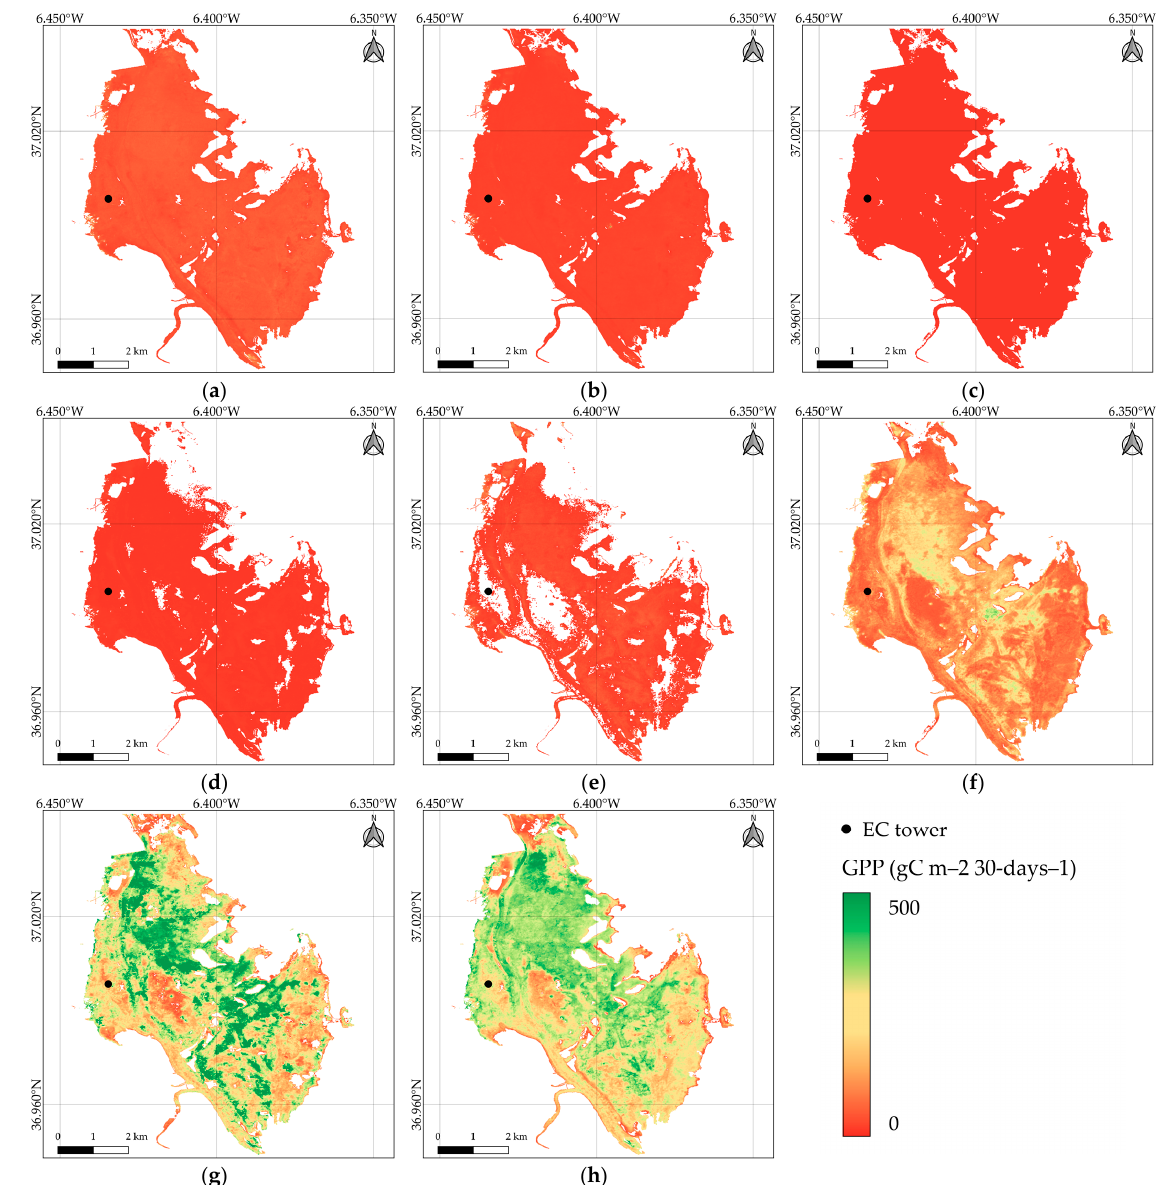
Figure 12. Monthly GPP maps obtained using a single composite image per month. The maps show the spatial and temporal pattern of GPP (gC m − 2 month − 1 ). ( a ) October 2020, ( b ) November 2020, ( c )